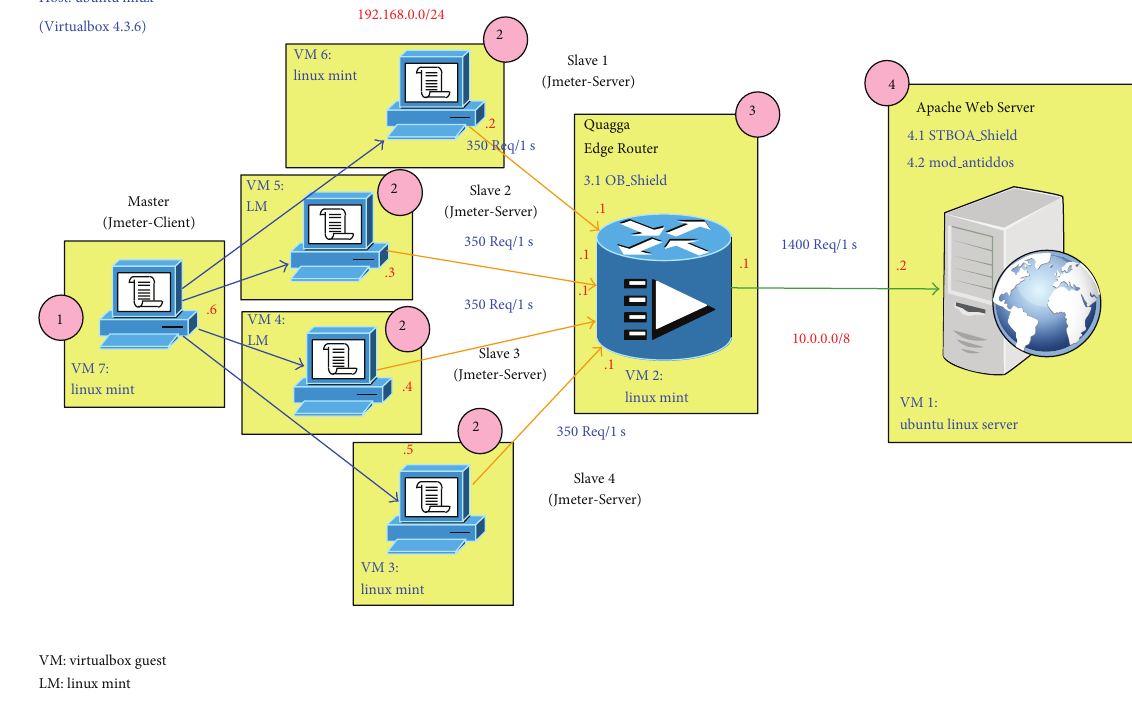
Figure 9: Sequential steps of simulation